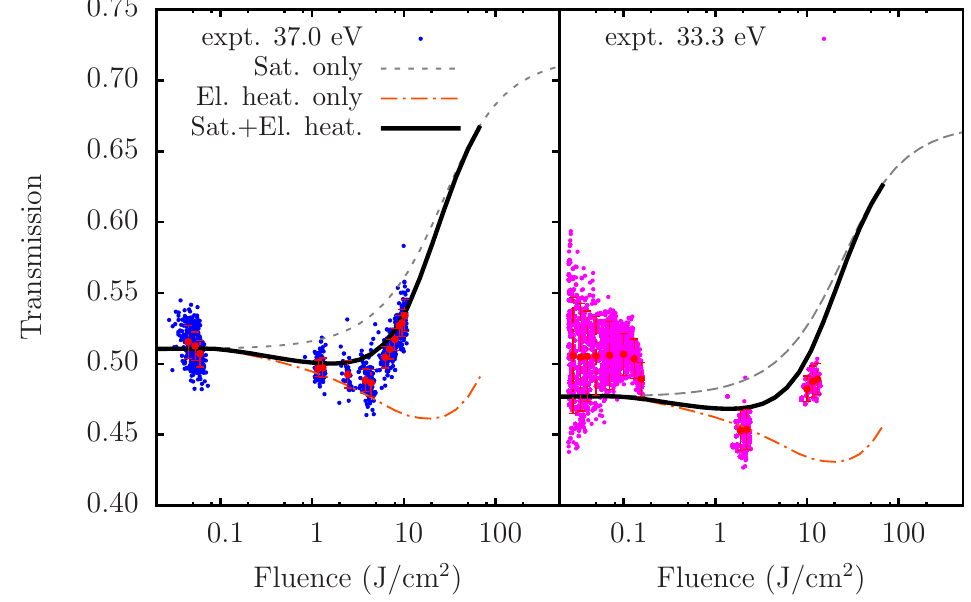
Figure 5. Experimental (expt.) EUV transmission data at 37 eV ( left panel ) and 33.3 eV ( right panel ) compared with different calculations, including: only optical saturation phenomena without accounting for temperature effects in the cross-section (Sat. only); only electron heating but neglecting saturation effects (El. heat. only); both electron heating and saturation effects (Sat.+El.